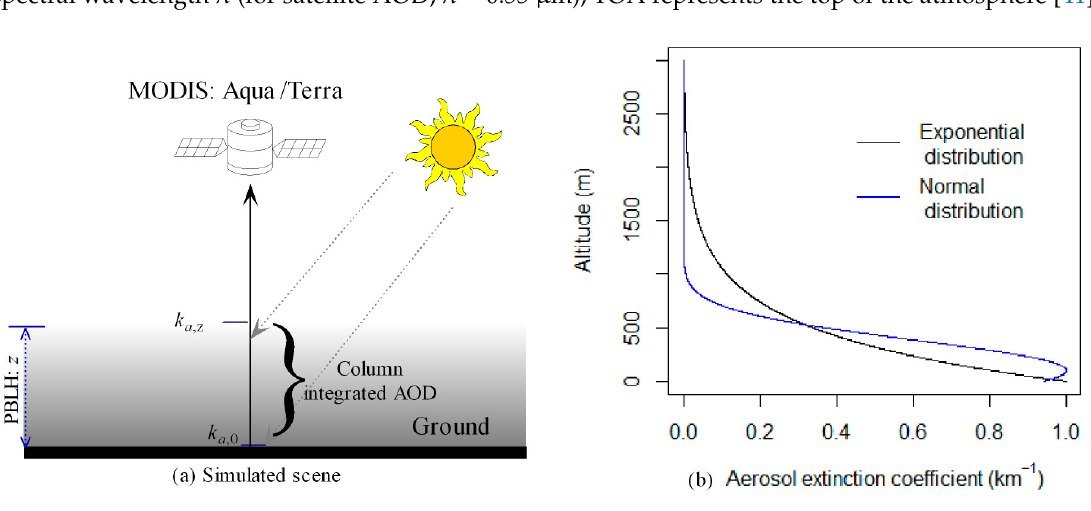
Figure 2. Relationship between satellite aerosol optical depth (AOD), ground aerosol extinction coefficient, and PBLH ( a ), and vertical exponential distribution ( b ) of aerosol extinction